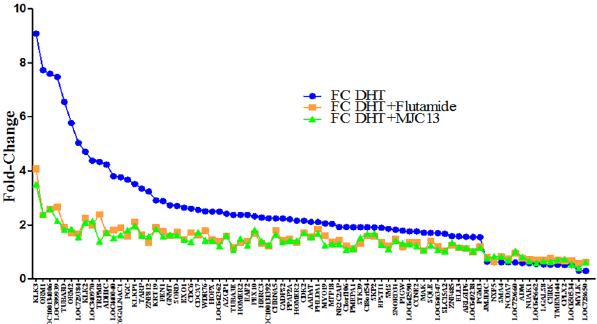
Fig 2. AR target genes are inhibited by MJC13 and Flutamide. Graph representing results of array analysis performed on LNCaP cells treated for 24 hours +/- DHT (1nM), +/- Flutamide (1 μ M), or +/- MJC13 (30 μ M) and displaying probe sets in which DHT response is inhibited by MJC13 and Flutamide. The first line (blue) represents DHT responses obtained in the presence of DMSO, second line (orange) represents DHT responses obtained in the presence of Flutamide. The third line (green) represents DHT responses obtained in the presence of MJC13.